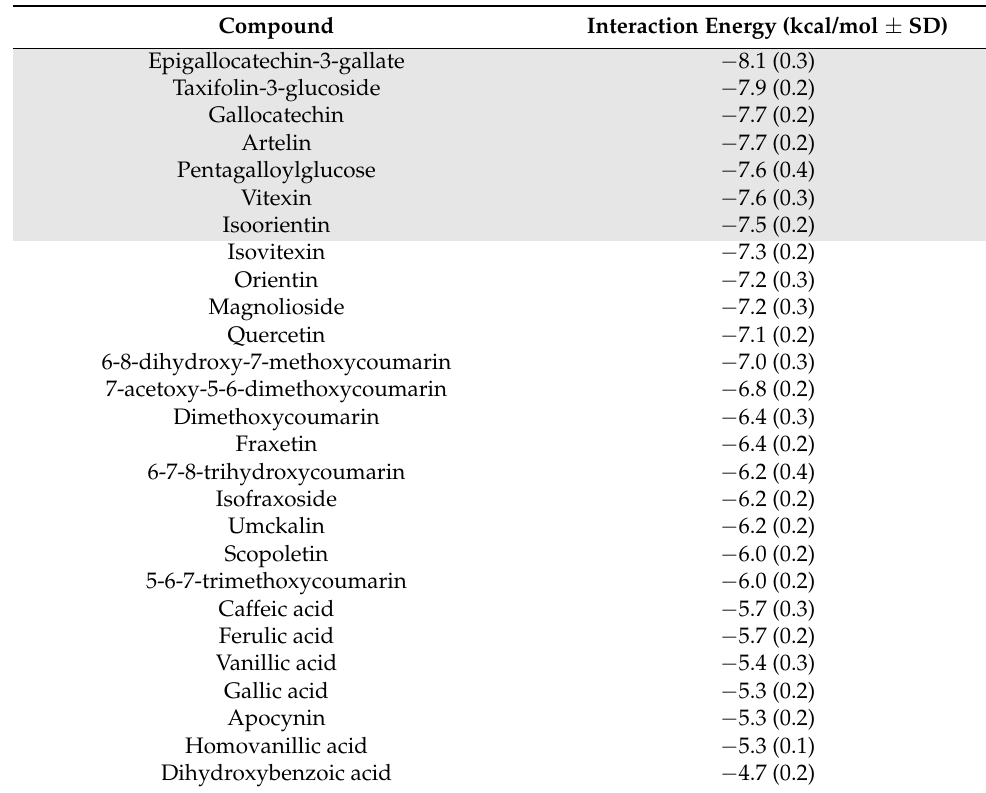
Table 1. Bovine lactoferrin molecular docking results. The average interaction energy calculated from three independent docking runs, including standard deviation, is reported for each compound.